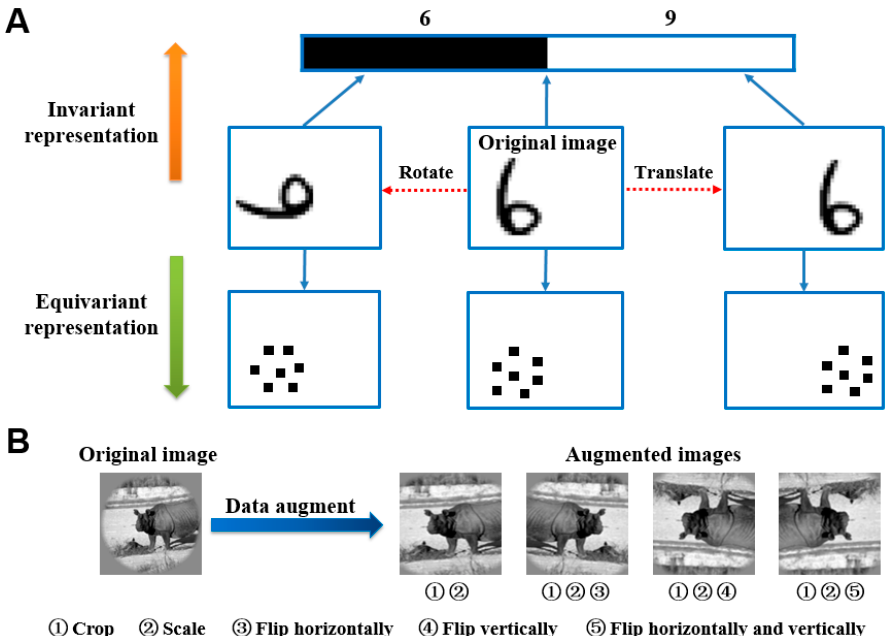
Figure 1. Feature representation and data augmentation technology. ( A ) Invariant representation and equivariant representation. The original image is rotated and translated to generate new images. The upward direction is an invariant representation, mostly for senior semantic features such as category. For example, “6” will be classified as 6 or 9. Conversely, the upward direction is an equivariant representation, mostly for low-level features, such as position and texture. ( B ) Data augmentation technology. The data augmentation image library (right) is obtained by cropping, scaling, and flipping sequentially (left).